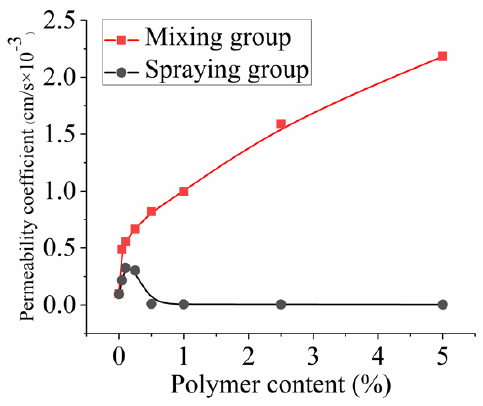
ffi cient of each group of Figure 4. Permeability coefficient of each group of samples. Figure 4. Permeability coe